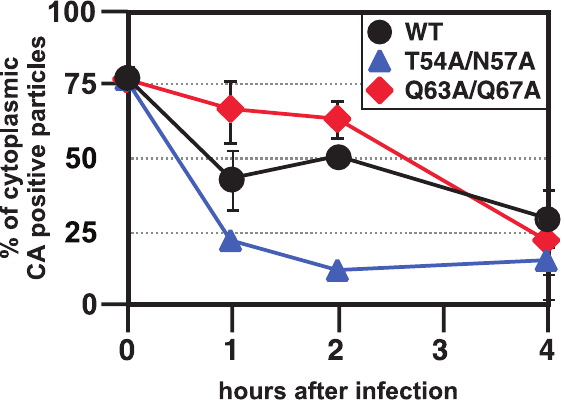
Figure 4. In Situ Analysis of Kinetics of p24 Loss from Cytoplasmic HIV HeLa cells were spinoculated with VSV-g pseudotyped, S15-mCherry, GFP-Vpr labeled HIV-1 D Env virions for 2 h at 17 8 C. Infection was synchronized by washing off innocula and replaced with 37 8 C media. HeLa cells were then fixed and immunostained for p24 CA (Cy-5) at the indicated time post infection and imaged. GFP ( þ ) pucnta were then quantified and individually examined for the presence of mCherry and Cy-5 (p24 CA ) signal. The identity of the samples was blinded before the experiment. The percentage of the total number of virions that have stained for p24 CA over time following fusion is shown. The 0-h time point represents total number of GFP ( þ ) virions that stained positive for p24 CA . HIV WT is represented by black lines/circles, the Q63/67A CA mutant by red line/diamonds, and the T54A/N57A CA mutant by blue line/triangles. The results shown are from three independently performed experiments and the standard deviation at each time point is